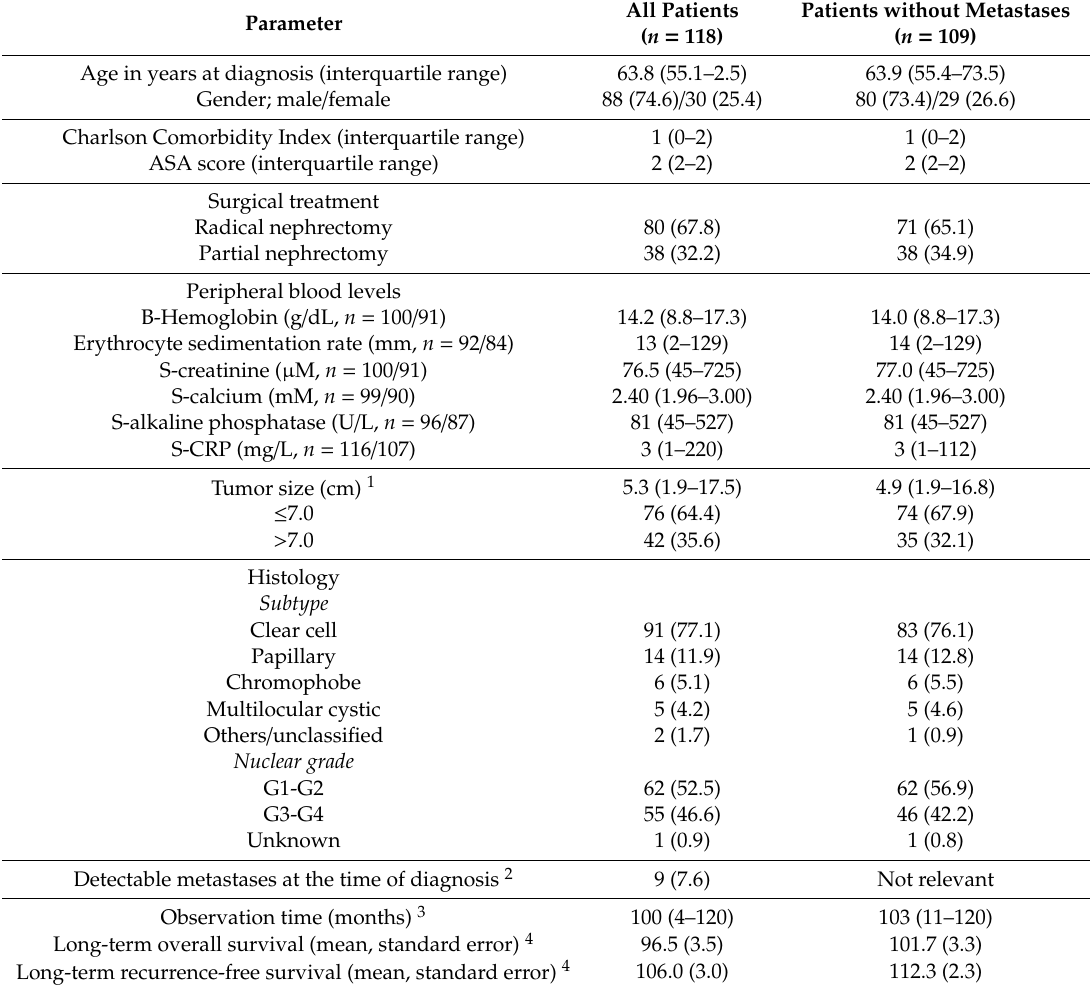
Table 1. Clinical and tumor characteristics of patients with renal cell carcinoma scheduled for surgery during the period 2007–2010; the table presents the results for all 118 patients for whom a preoperative serum sample was available (unless otherwise specified) and for the patients with local renal cancer disease (i.e., without metastases). The results are presented as the median and interquartile (if specified) range for continuous variables, except for long-term survival. Categorical data are expressed as numbers with a percentage (or in specified cases interquartile range) in